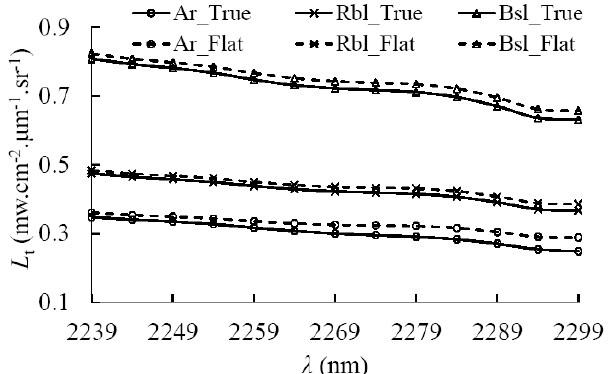
Figure 11. Calculated sensor radiance ( L t ) with respect to wavelength ( λ )simulated for background XCH 4 . Solid lines show L t for the true ρ s ( λ ) (denoted “_True”) for spectra for scene elements Asphalt road (Ar), Brown sandy loam (Bsl), and Reddish-brown fine sandy loam (Rbl) shown in Figure 3. Dashed lines show L t for constant (cid:36) s (2139) across the feature (denoted